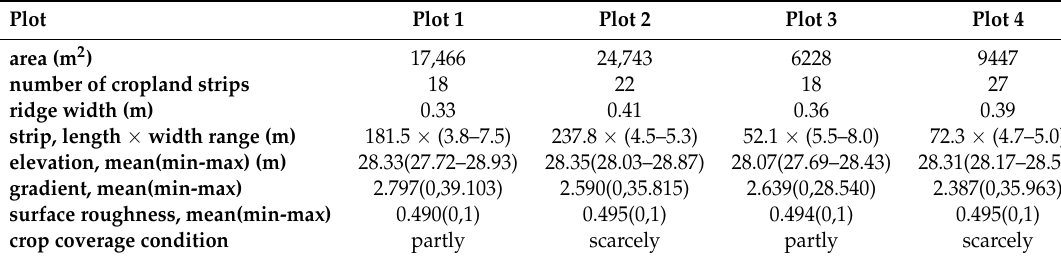
Table 3. Specific parameters of four